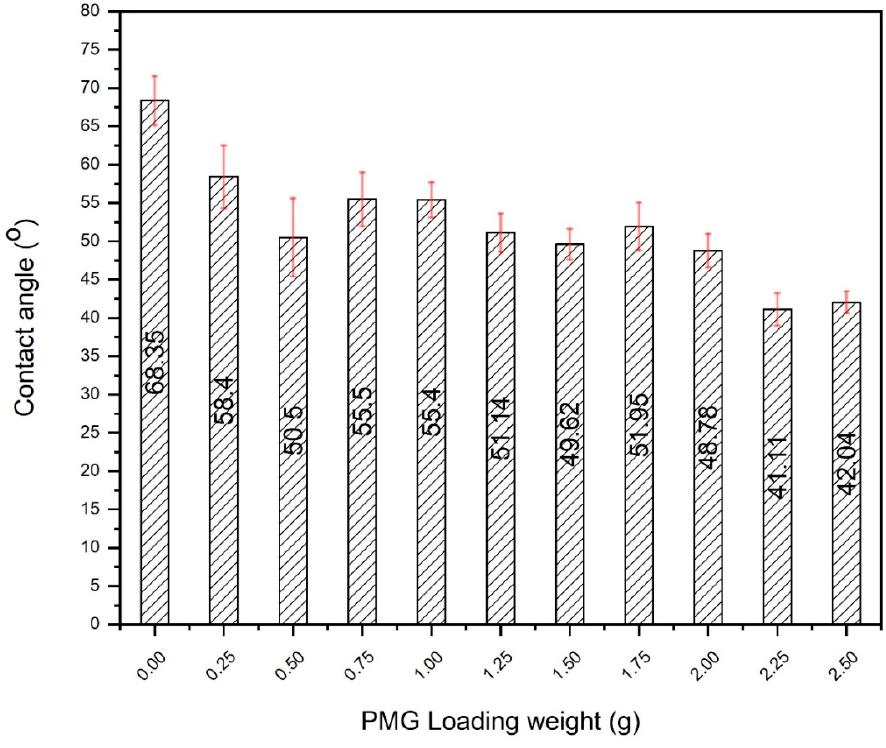
Figure 10. Contact angle measurement of the PMG NPs’ modified membranes.